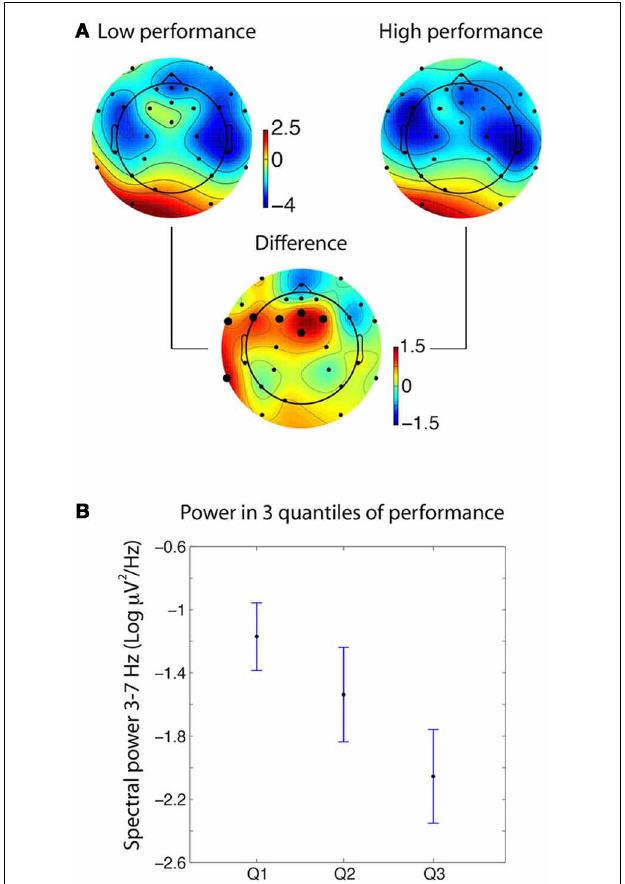
FIGURE 2 | Spectral differences in the theta frequency band for medium M1. (A) Scalp topography of theta power during the mental experiences of information later rated as low ( < 50%) or high ( ≥ 50%) in accuracy [the unit being 10 ∗ log 10 ( µ V 2 )]. The large dots on the differential scalp topography indicate significance at p < 0 . 005. (B) When splitting the data into three quantiles of increasing accuracy (i.e., 0–34; 40–80; and 100% accuracy), theta power for the intermediate accuracy level fell in between the high and low accuracy levels. Error bars indicate 95% confidence